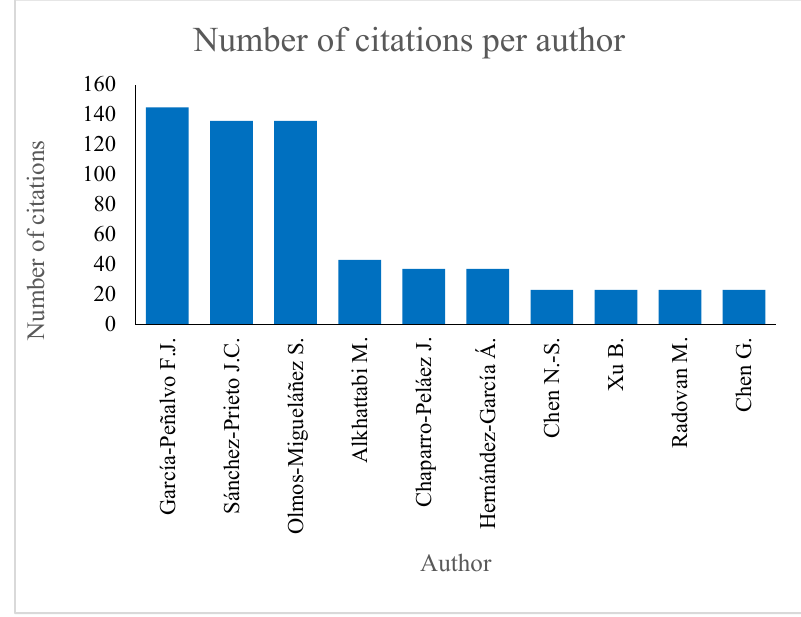
Figure 6. Number of citations per author. Own elaboration from SCOPUS data. Table 1. Main topics and areas of study of the most cited authors of publications on virtual tools in teaching-learning processes.